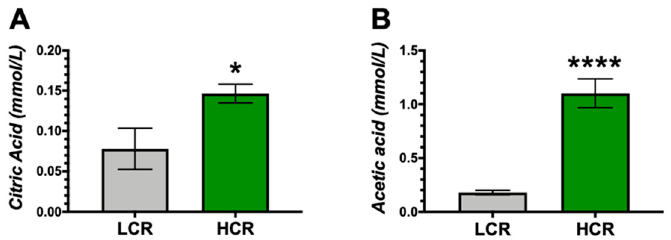
Figure 6. Plasma markers of mitochondrial activity in LCR and HCR rats. ( A ) Plasma levels of citric acid. ( B ) Plasma levels of acetic acid. * p < 0.05 as compared to LCR rats. **** p < 0.001 as compared to LCR rats. n = 9/group.